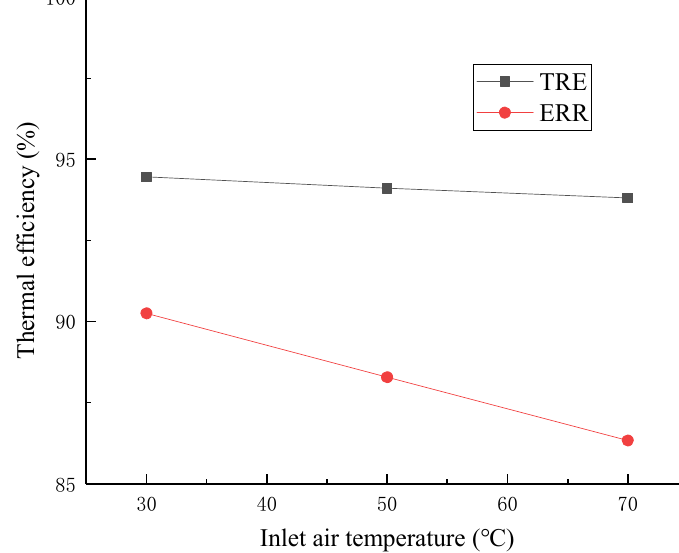
Figure 10. Effect of inlet air temperature on heat transfer efficiencies.